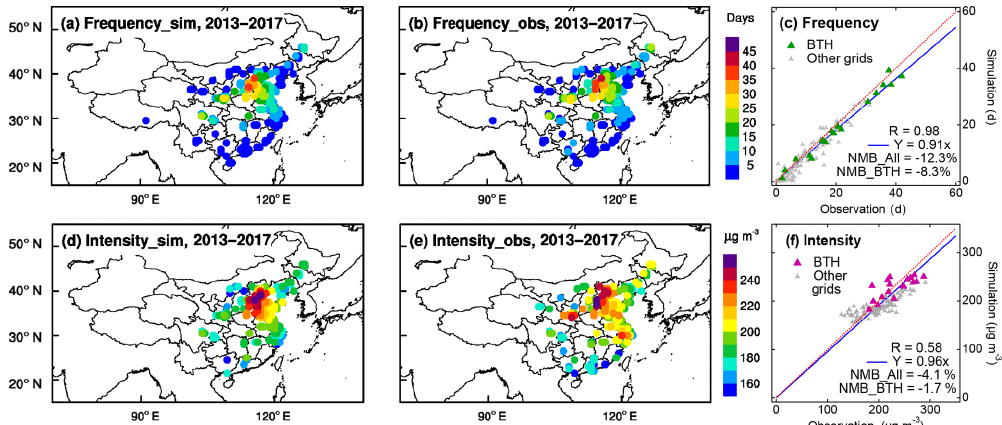
Figure 4. Spatial distributions of (a) simulated and (b) observed frequencies (days) of SWHDs averaged from 2013 to 2017 at 161 model grids in China and (c) scatterplot of simulated versus observed results in (a) and (b) ; panels (d–f) are the same as (a–c) except that the values are SWHD intensities (µgm − 3 ). Also shown in the scatterplots are y = x lines (dashed), linear fits (solid line and equation), correlation coefficients ( R ), and NMB values.